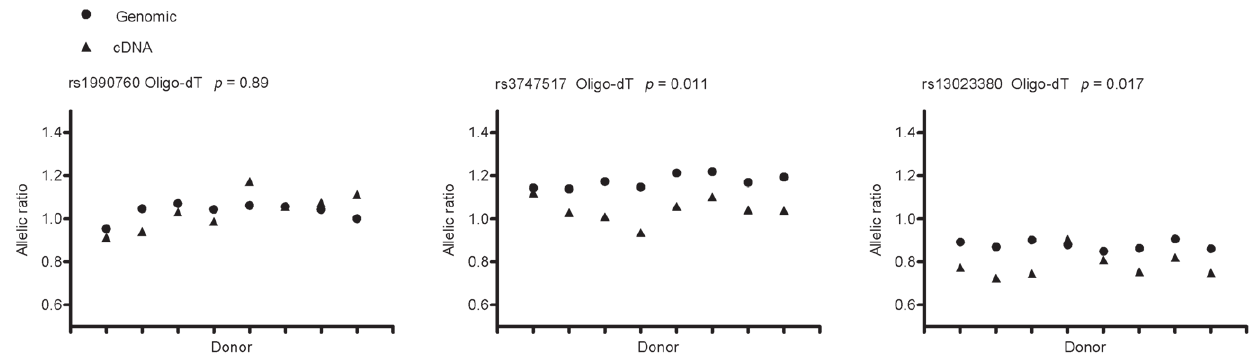
Figure 1. Allele specific expression of IFIH1 pre mRNA transcript for the common T1D haplotype in IFN- b stimulated PBMCs. The mean allelic ratio is a measure of the ratio of the sequencing trace peak heights for the heterozygous SNP within genomic and cDNA from each individual (overall sign-rank p =0.012).